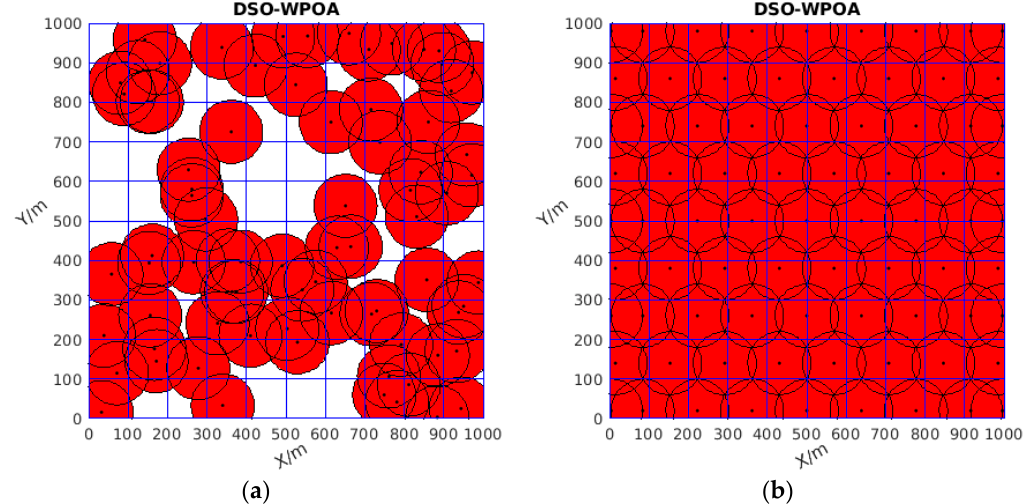
Figure 8. ( a ) The initial diagram of wireless sensor network coverage (distributed randomly); ( b ) the coverage optimized by DSO-WPOA.